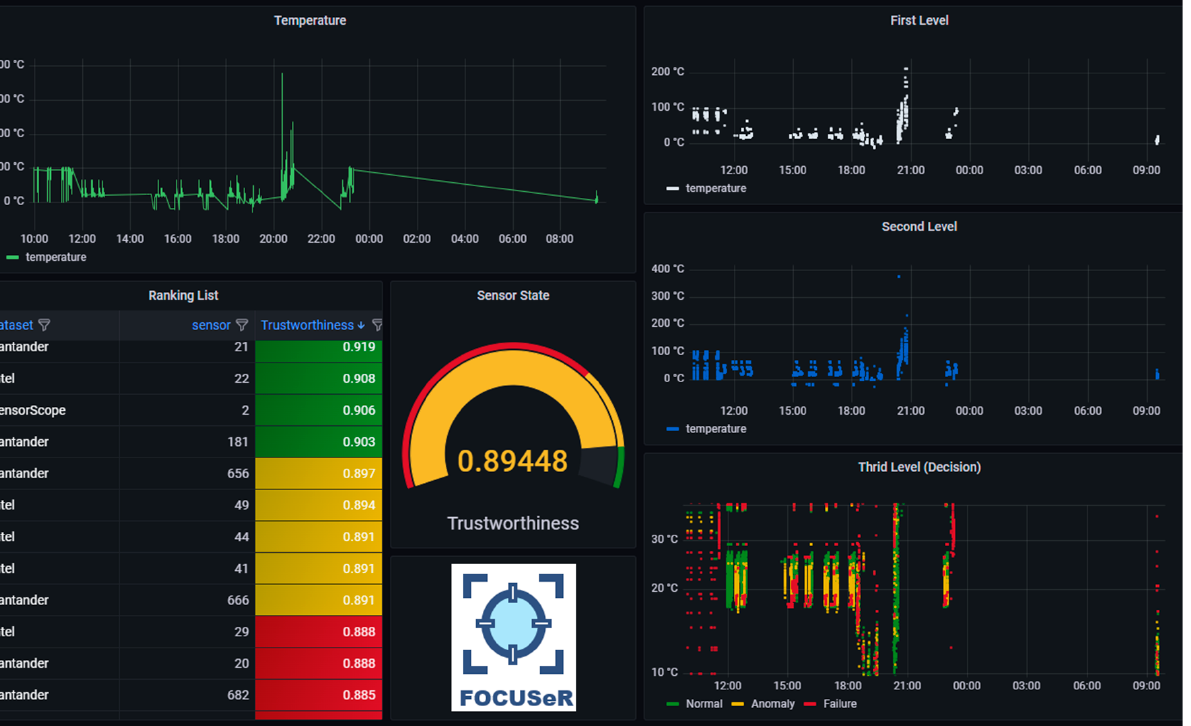
Figure 16. An example of a monitoring dashboard also displaying the ranking list. The monitoring panel shown in the image includes sensor value monitoring (top left); the results of the evaluation at the different levels of the proposal (right); and the ranking list of sensors classified using the trustworthiness parameter (bottom left).